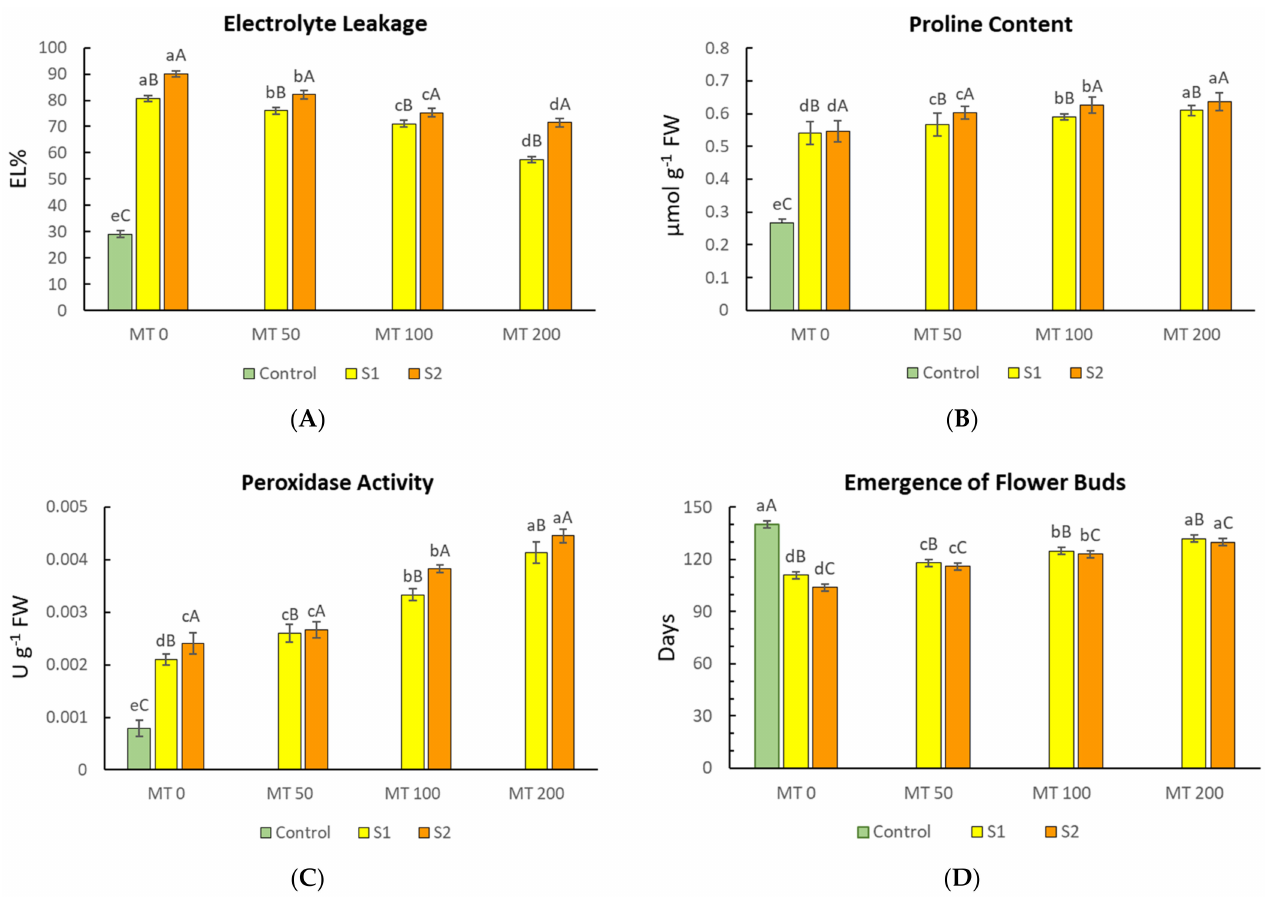
Figure 2. The effects of exogenous melatonin application (0, 50, 100, and 200 µ M) on electrolyte leakage ( A ), proline content ( B ), peroxidase enzymes activity ( C ), and flower bud emergence time ( D ) of R. asiaticus under saline conditions. Control: no stress and no melatonin; S1: plants under salt stress EC 4.5 dS · m − 1 ; S2: plants under salt stress EC 5.5 dS · m − 1 different letters are for significantly different groups (Tukey/Dunnett p < 0.05). The lowercase letters are for significant differences amongst melatonin concentrations under fixed salinity treatments, while the uppercase letters are for significant differences in the salinity treatments with the control group under fixed melatonin concentration levels ( n ≥